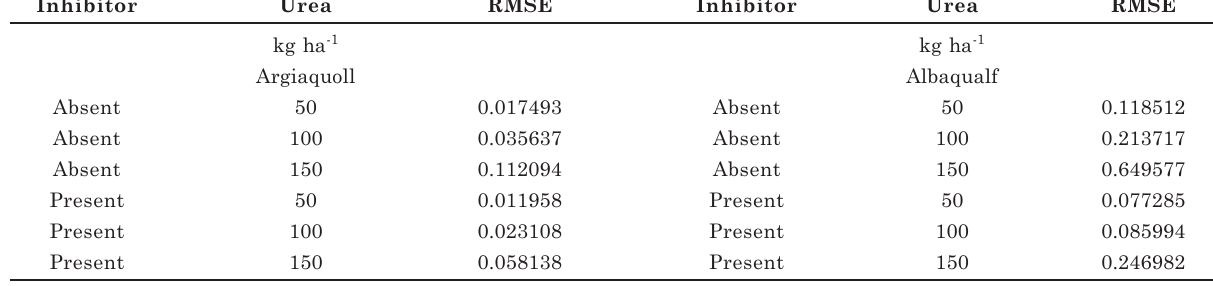
Table 3. Average root mean squared error (RMSE) from model adjustment by the Gauss-Newton iterative method for each treatment